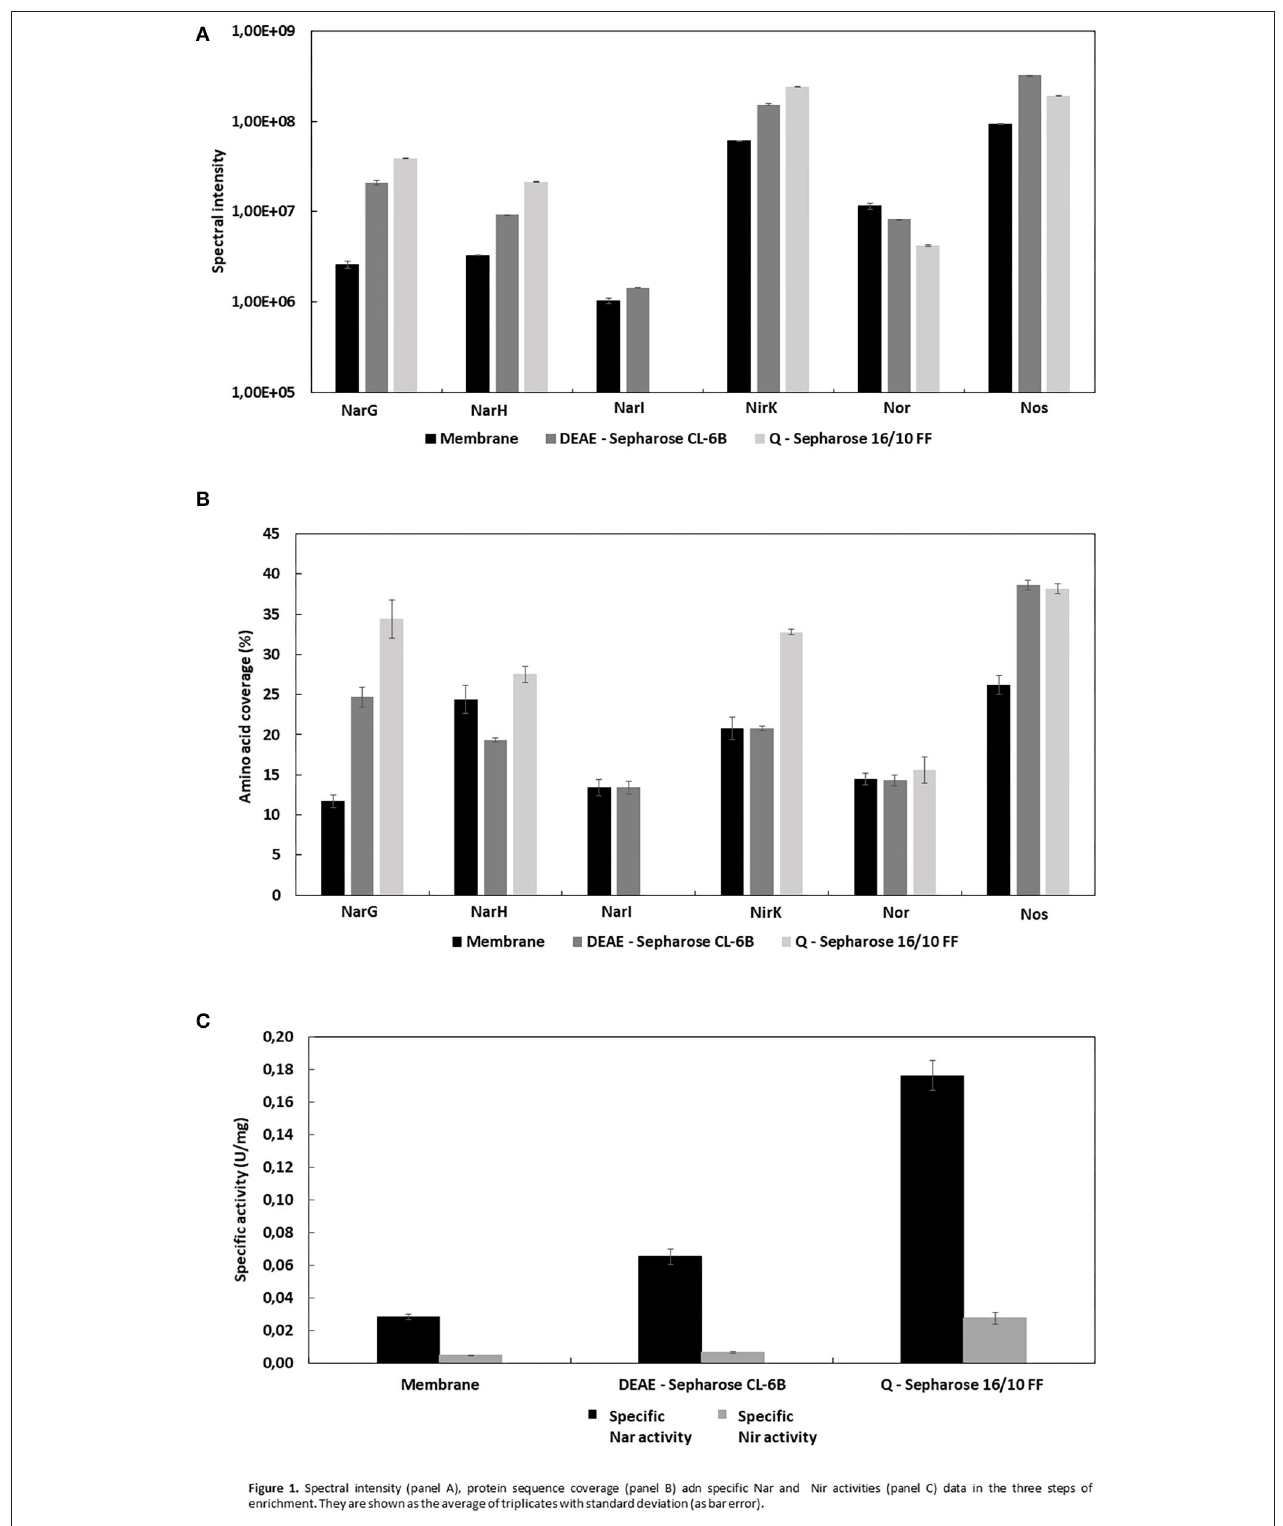
FIGURE 1 | Spectral intensity (A) , protein sequence coverage (B) adn specific Nar and Nir activities (C) data in the three steps of enrichment. They are shown as the average of triplicates with standard deviation (as bar error).